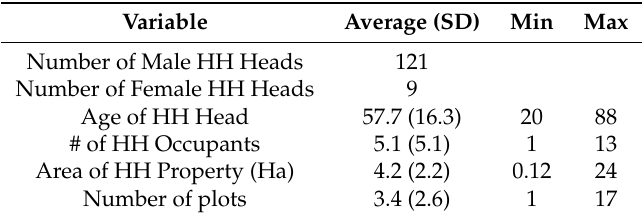
Table 2. General characteristics of the households (N = 130).